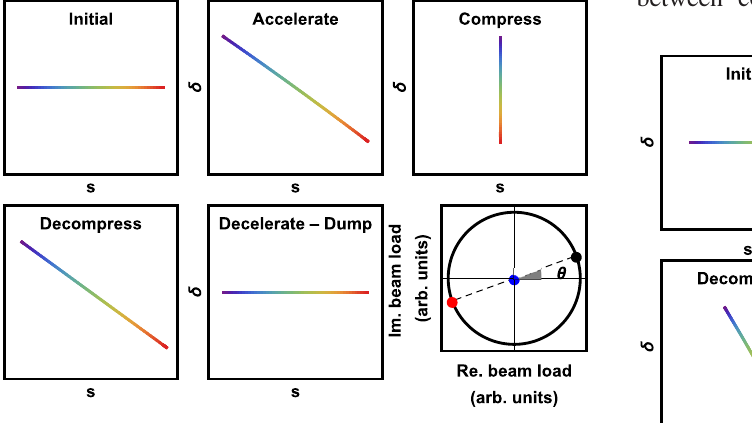
FIG. 3. Example I: Compressive match. Sequence of longi- tudinal phase space manipulations maximizing bunch current at interaction point. From top left: Initial, accelerated, compressed, decompressed and decelerated charge distributions. Bottom right shows the total rf load in the complex plane with rf phase choices during acceleration (black), deceleration (red), and resulting beam load (blue). To achieve zero chirp after deceleration we must decompress with opposite sign R 56 to that of the com- pression.